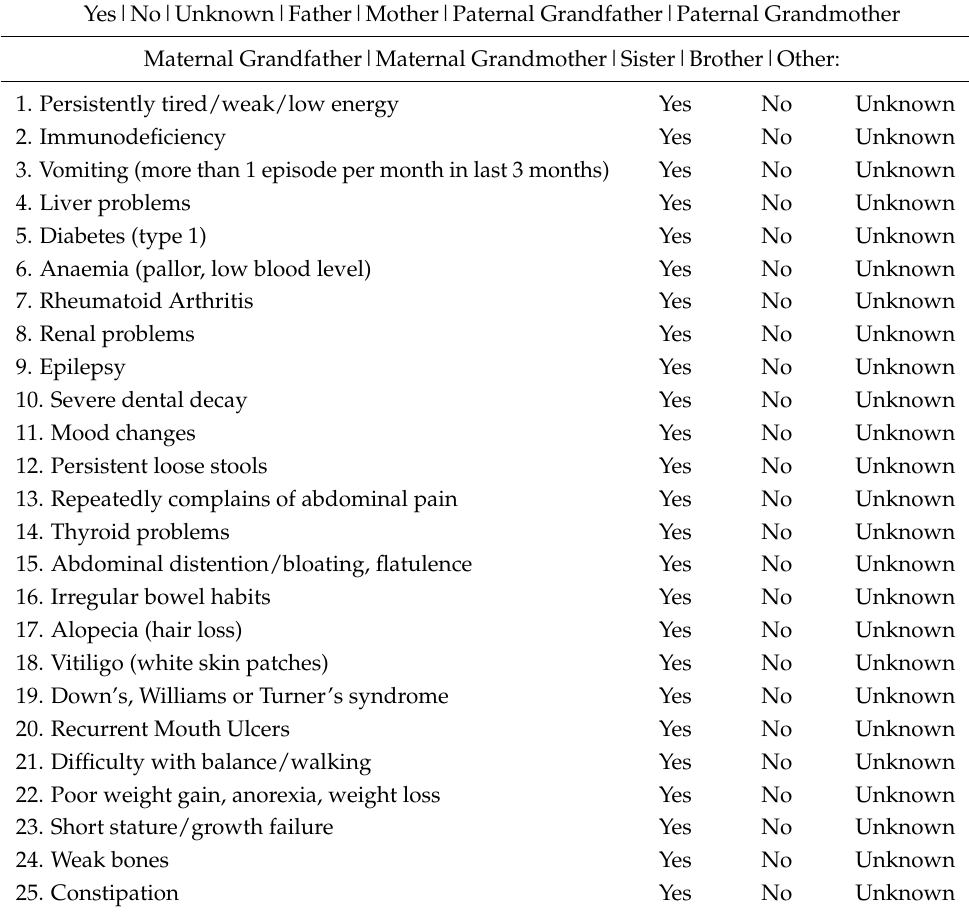
Table 2. Questionnaire utilized in Malta. Do You Have Any Family Relatives with Coeliac